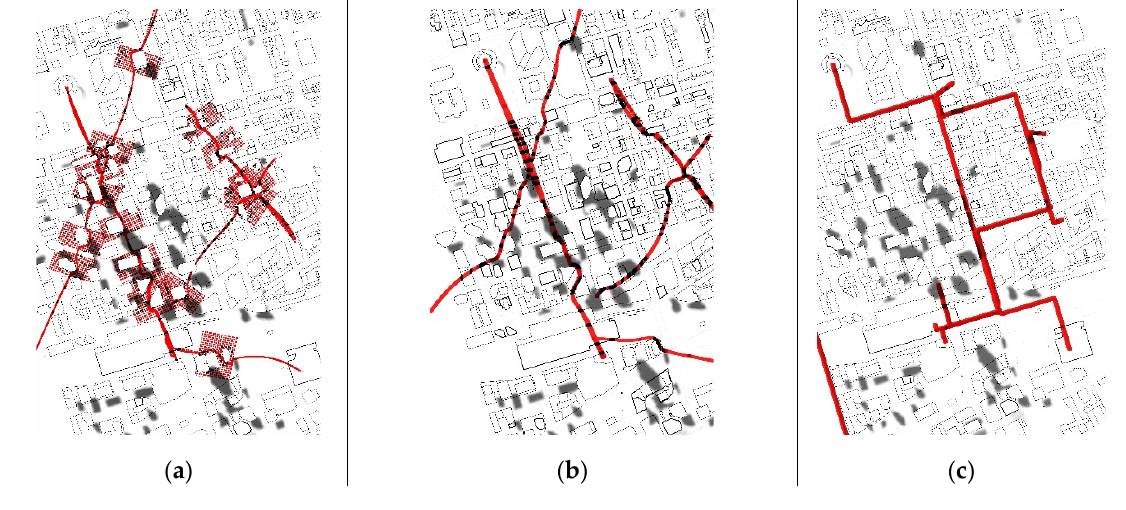
Figure 9. Results for assigned missions’ trajectory planning in the study area layout, scale 1:4000.